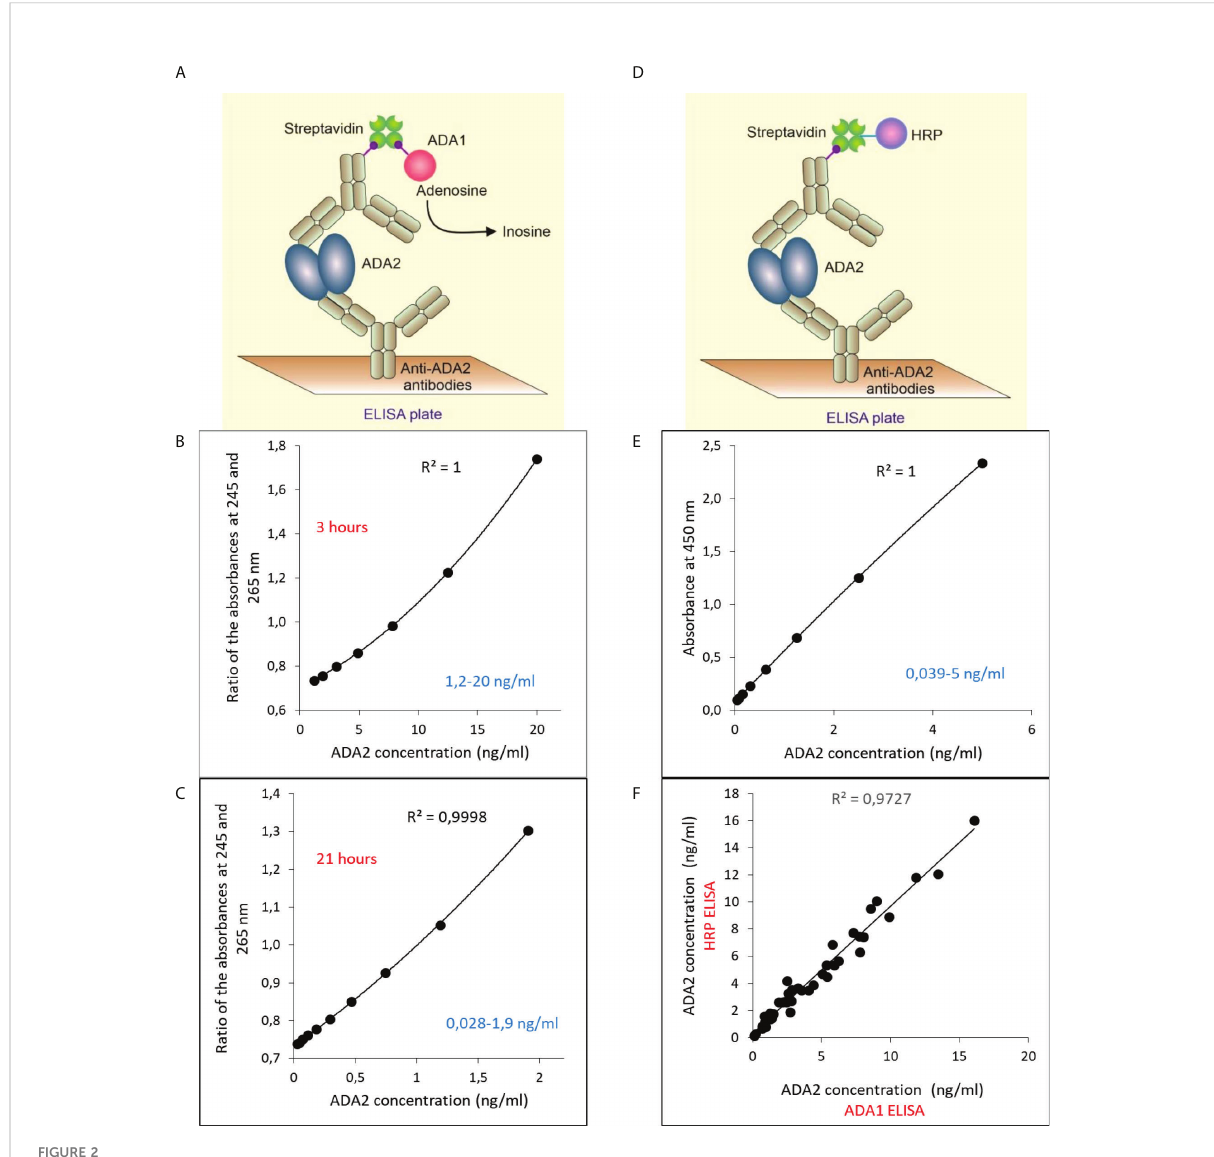
FIGURE 2 Sandwich ELISA for the detection of ADA2 with rabbit anti-ADA2 polyclonal antibodies. (A) Sandwich ELISA with mouse ADA1 (mADA1) as a detection enzyme. Typical standard curves were obtained with the ADA1 detection system after 3 hours (B) and 21 hours (C) of incubation with adenosine. (D) Sandwich ELISA with mouse HRP as a detection enzyme. A typical standard curve is shown in (E) . (F) Correlation between the results obtained for 47 saliva samples from children using mADA1 or HRP as detection